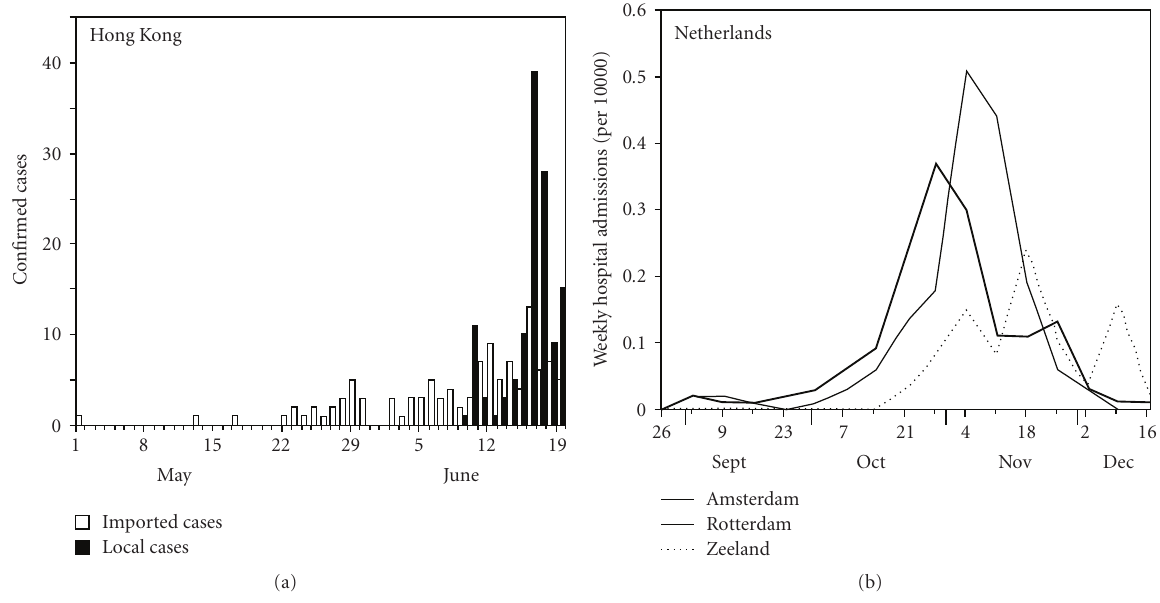
Figure 1: Epidemiology of the pandemic influenza A (H1N1-2009) in Hong Kong and the Netherlands. (a) Introduction of imported confirmed cases in Hong Kong followed by an increase in local (indigenous) confirmed cases from May–June, 2009 [25]. (b) The hospitalization rates of the influenza A (H1N1-2009) in Amsterdam, Rotterdam and Zeeland from August–December, 2009 [26]. Weekly numbers of hospitalizations are divided by the population size in each